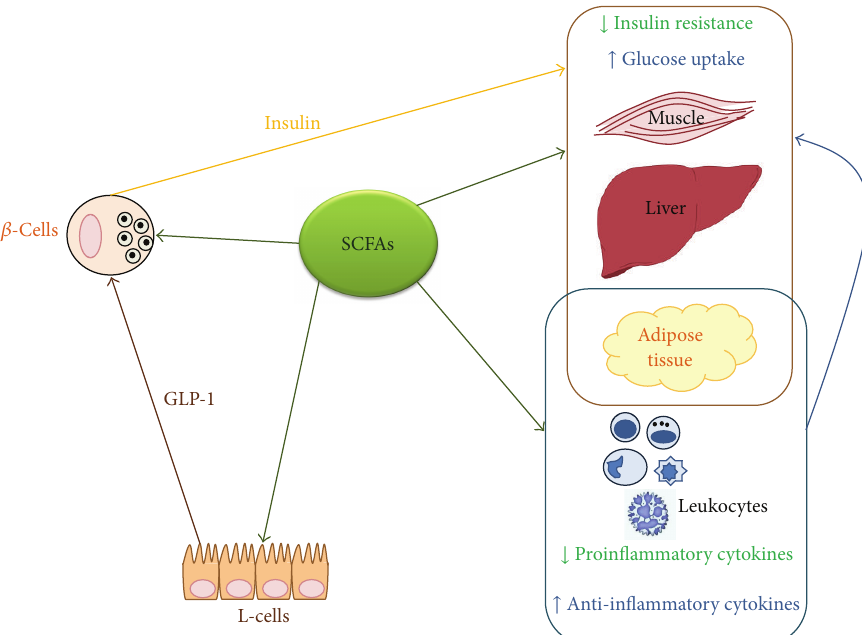
Figure 1: SCFAs improve metabolic functions in T2D. SCFAs were shown to affect pancreatic beta-cell function by directly acting as HDAC inhibitors (promoting 𝛽 -cell development, proliferation, and differentiation) or by indirectly increasing GLP-1 secretion from enteroendocrine L-cells (leading to insulin release). Furthermore, SCFAs reduce the release of proinflammatory cytokines by adipose tissue and weaken leukocyte activation. These anti-inflammatory effects improve insulin resistance, tissue glucose uptake, and blood glucose